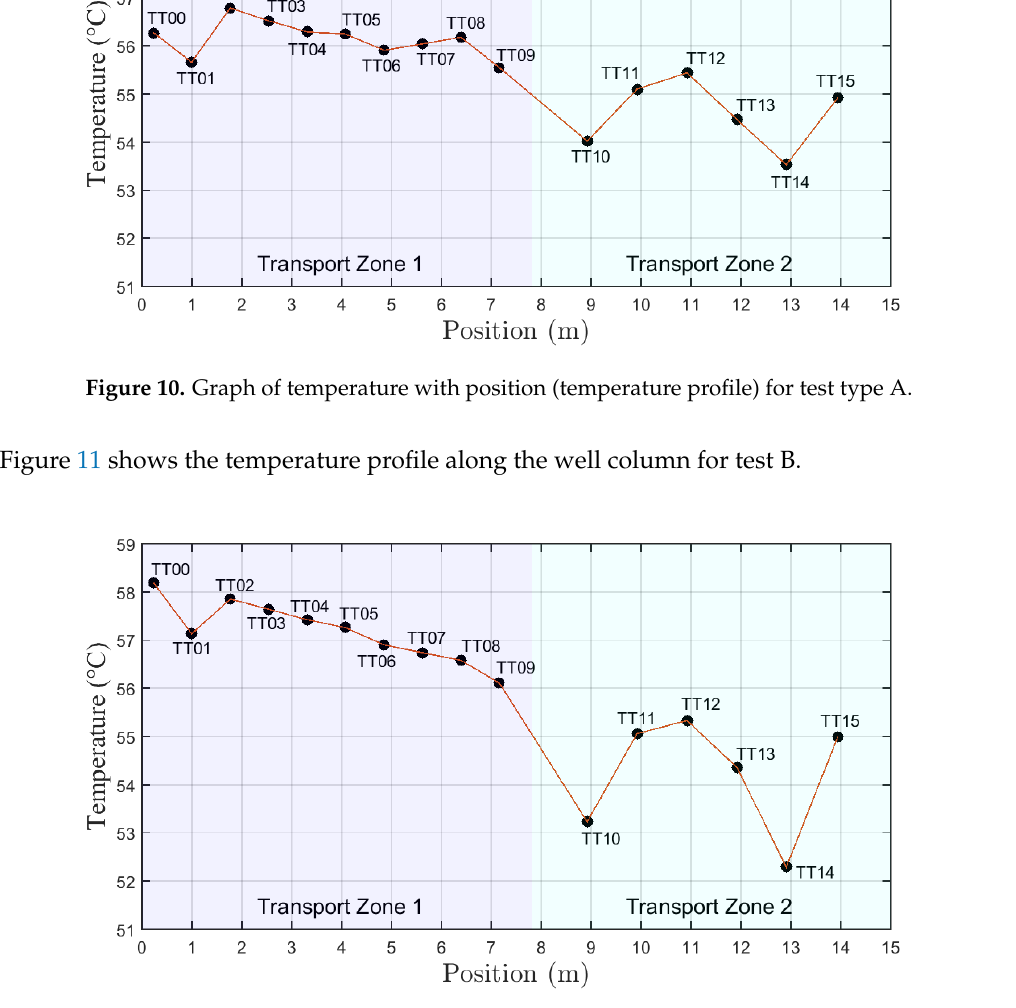
Figure 11. Graph of temperature with position (temperature profile) for test type